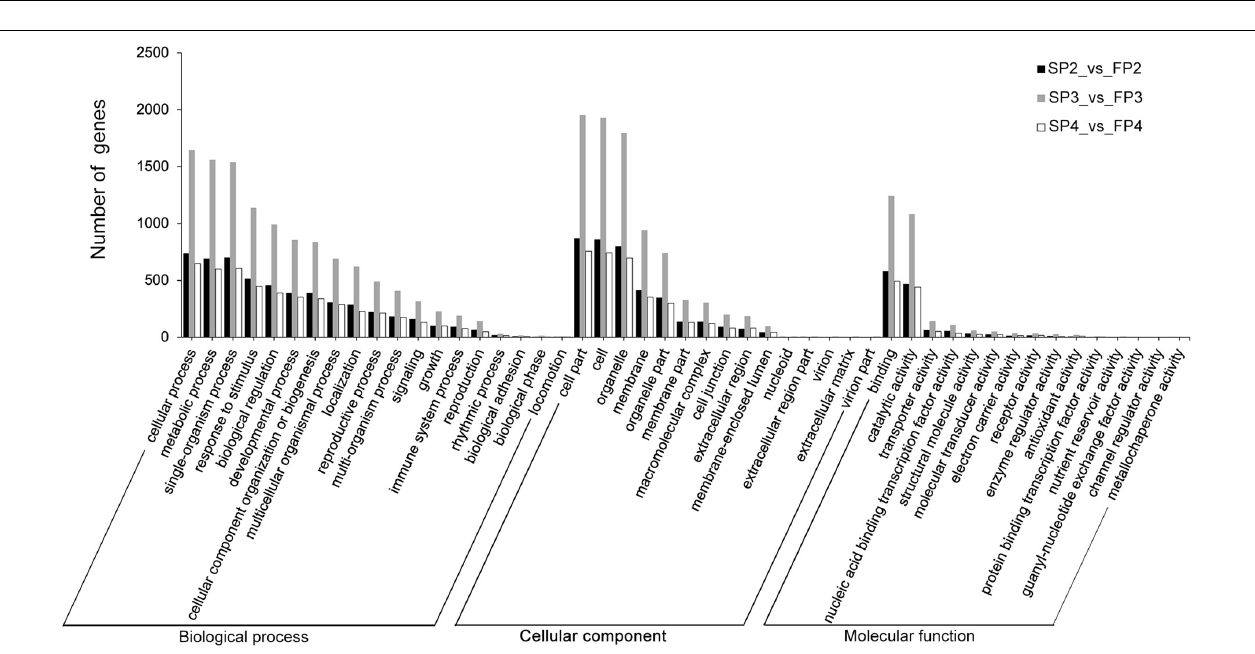
FIGURE 4 | Validation of RNA-Seq data for the expression patterns of 12 randomly selected DE-lncRNAs using quantitative RT-PCR. The error bars indicate ± SD of three biological replicates. OsActin1 was used as the internal reference.